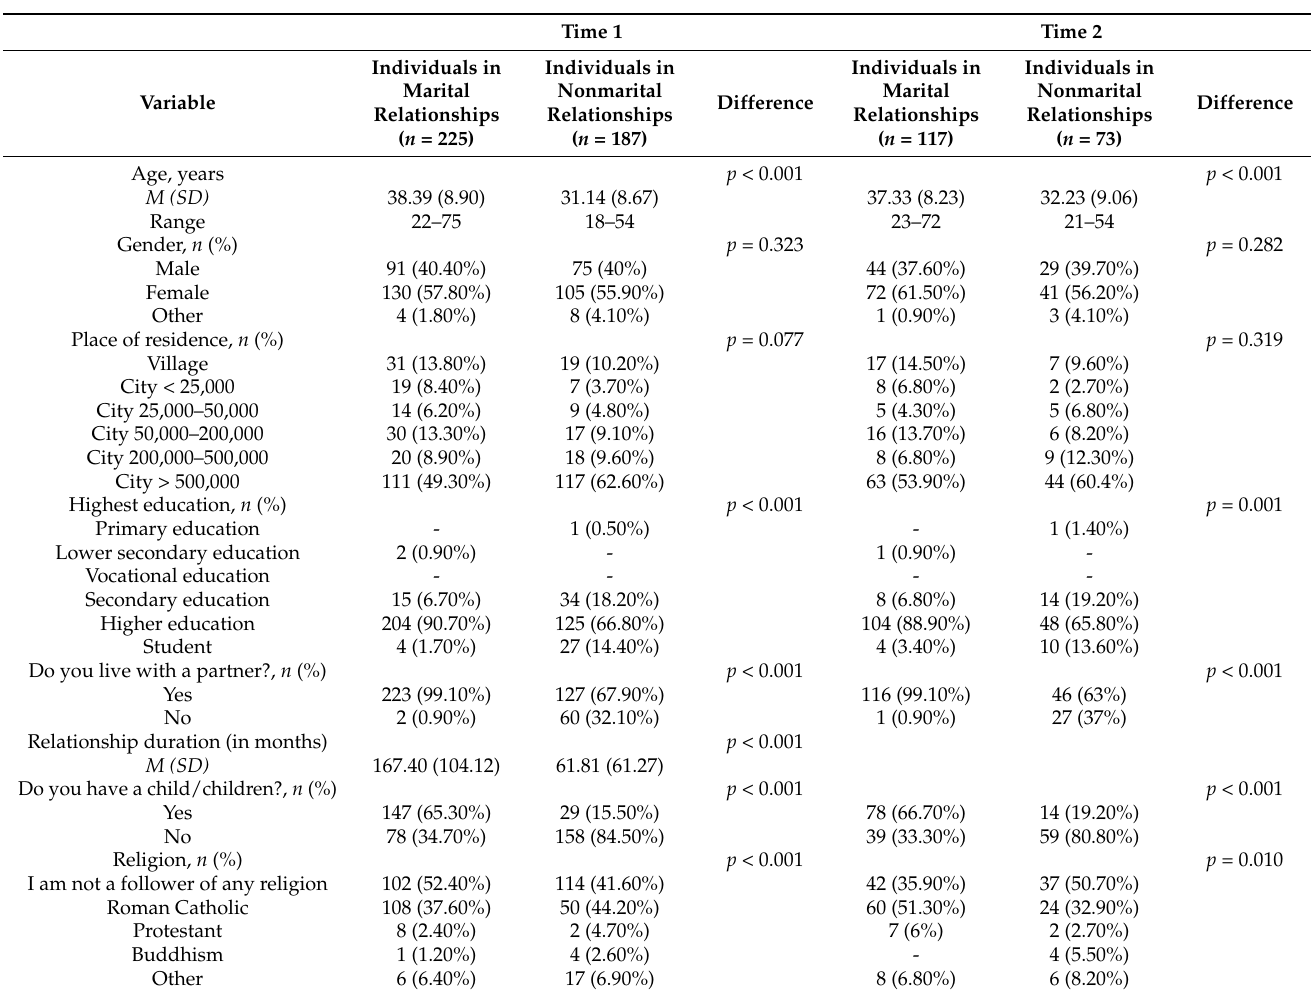
Table 3. Demographic Characteristics of Participants at T1 and T2 and as a Function of the Relation- ship